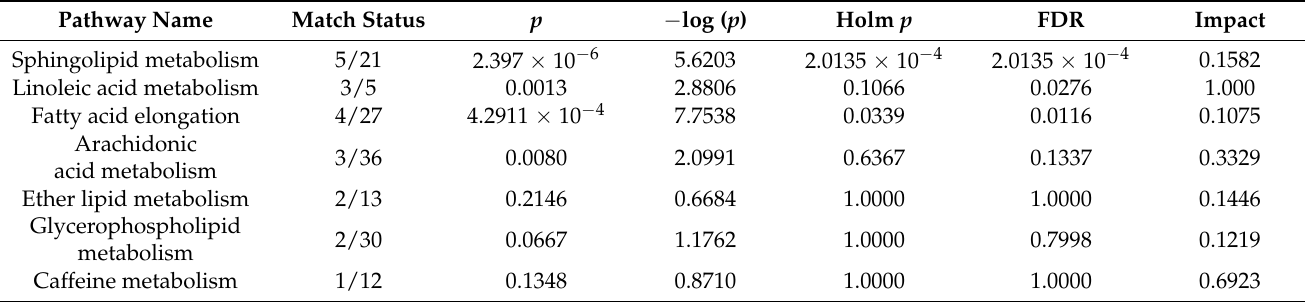
Table 4. The results from the metabolic pathways of differential